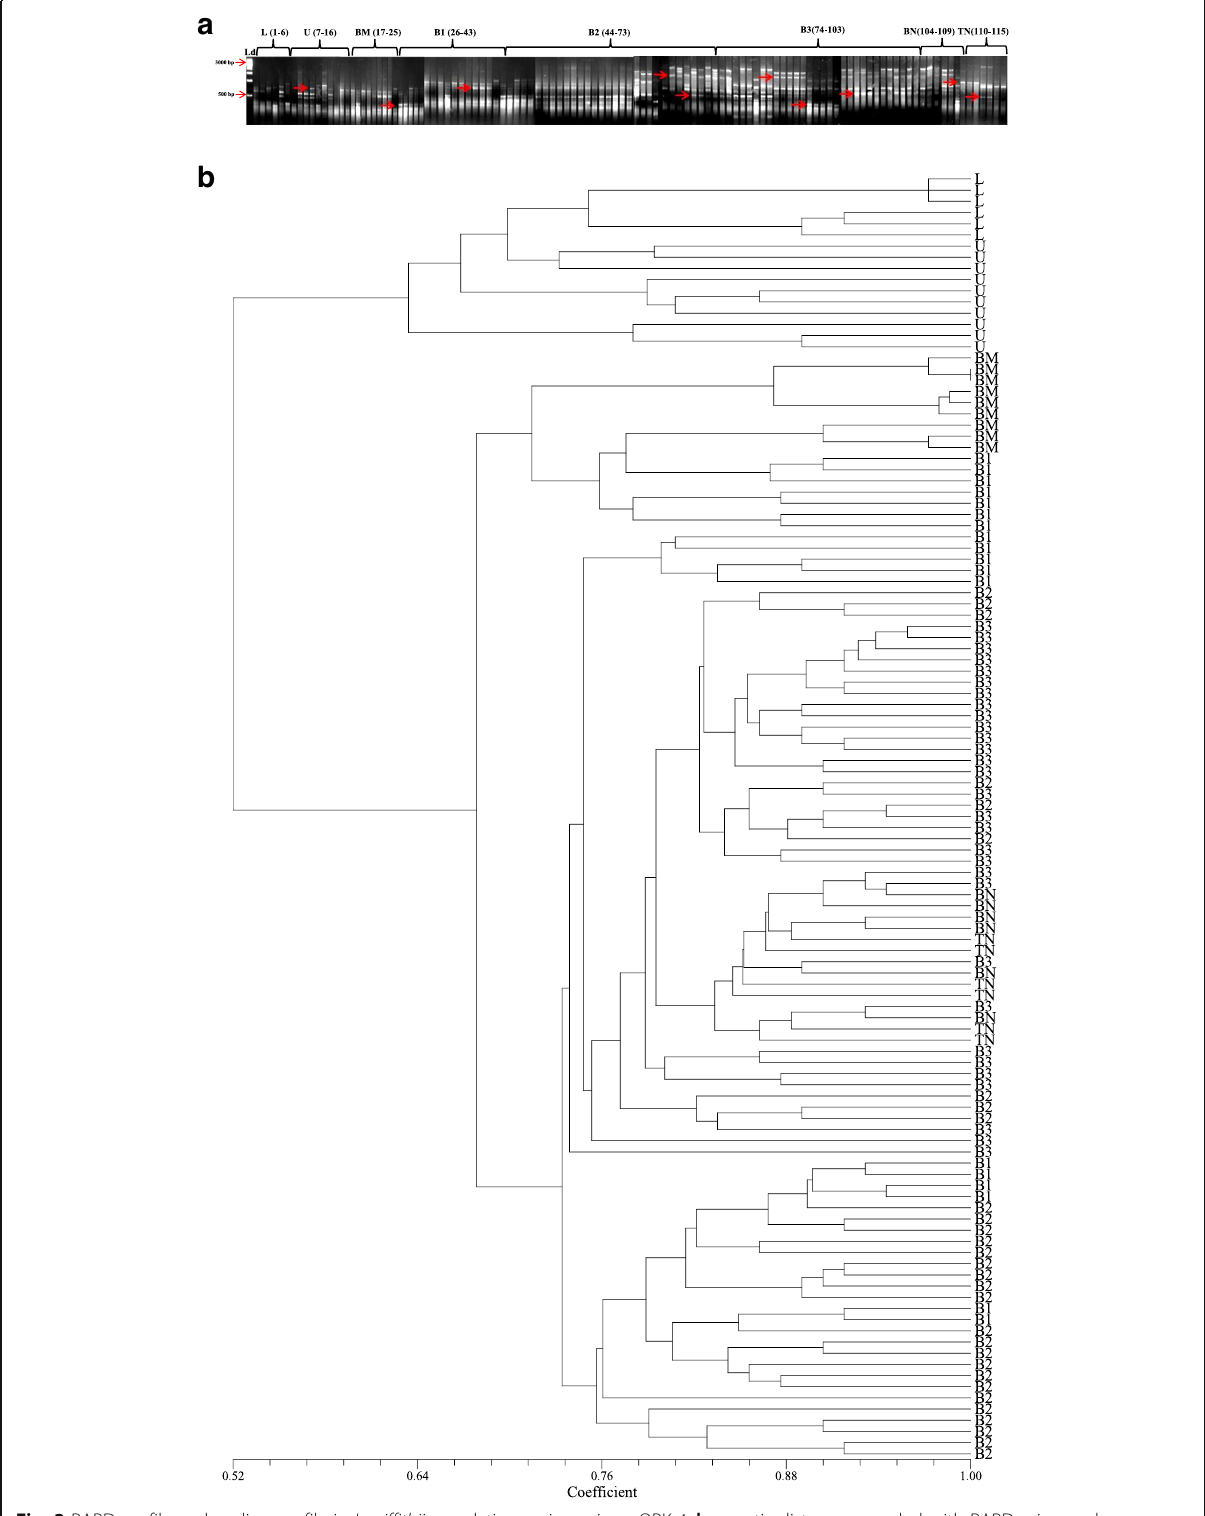
Fig. 3 RAPD profiles; a banding profile in I . griffithii populations using primer OPK-4, b genetic distance recorded with RAPD primers